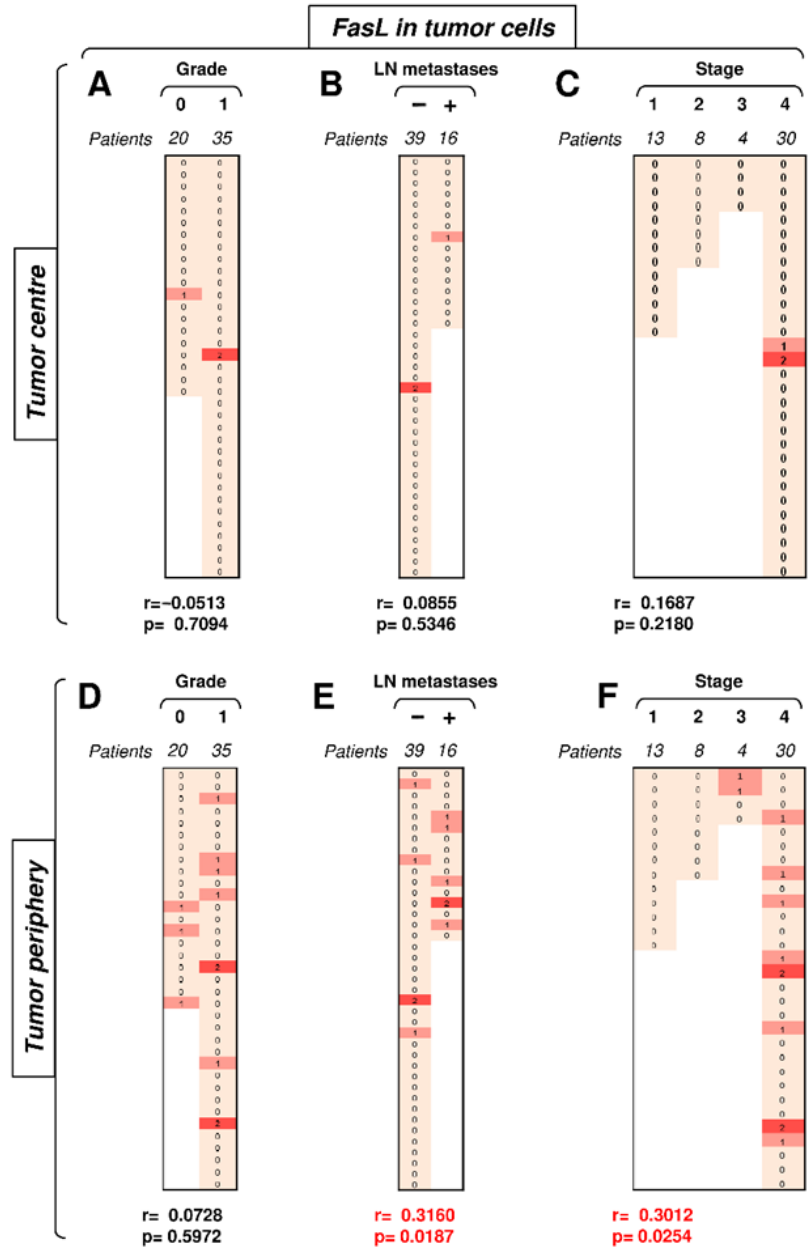
Figure 6. The expression of FasL in tumor cells in the tumor periphery correlates with tumor stage. ( A ) The cohort of 55 SGC patients was stratified into 2 groups according to tumor grade (grade 0 and grade 1), and the Spearman correlation ( r ) according to the expression of FasL in tumor cells in the tumor center was determined. The expression analyses were performed according to the scoring system described in the Materials and Methods section. The data are presented as a heat map with the indicated scores. The calculated p < 0.05 (red) was considered significant. ( B ) The patient cohort in ( A ) was stratified into 2 groups according to the absence ( − ) or presence (+) of lymph node (LN) metastases, and the Spearman correlation ( r ) was determined as in ( A ). ( C ) The patient cohort in ( A ) was stratified into 4 groups according to the primary tumor stage, and the Spearman correlation ( r ) was determined as in ( A) . ( D – F ) The cohort of 52 SGC patients was stratified into groups as in ( A – C ), and the Spearman correlation ( r ) according to the expression of FasL in tumor cells in the tumor periphery was